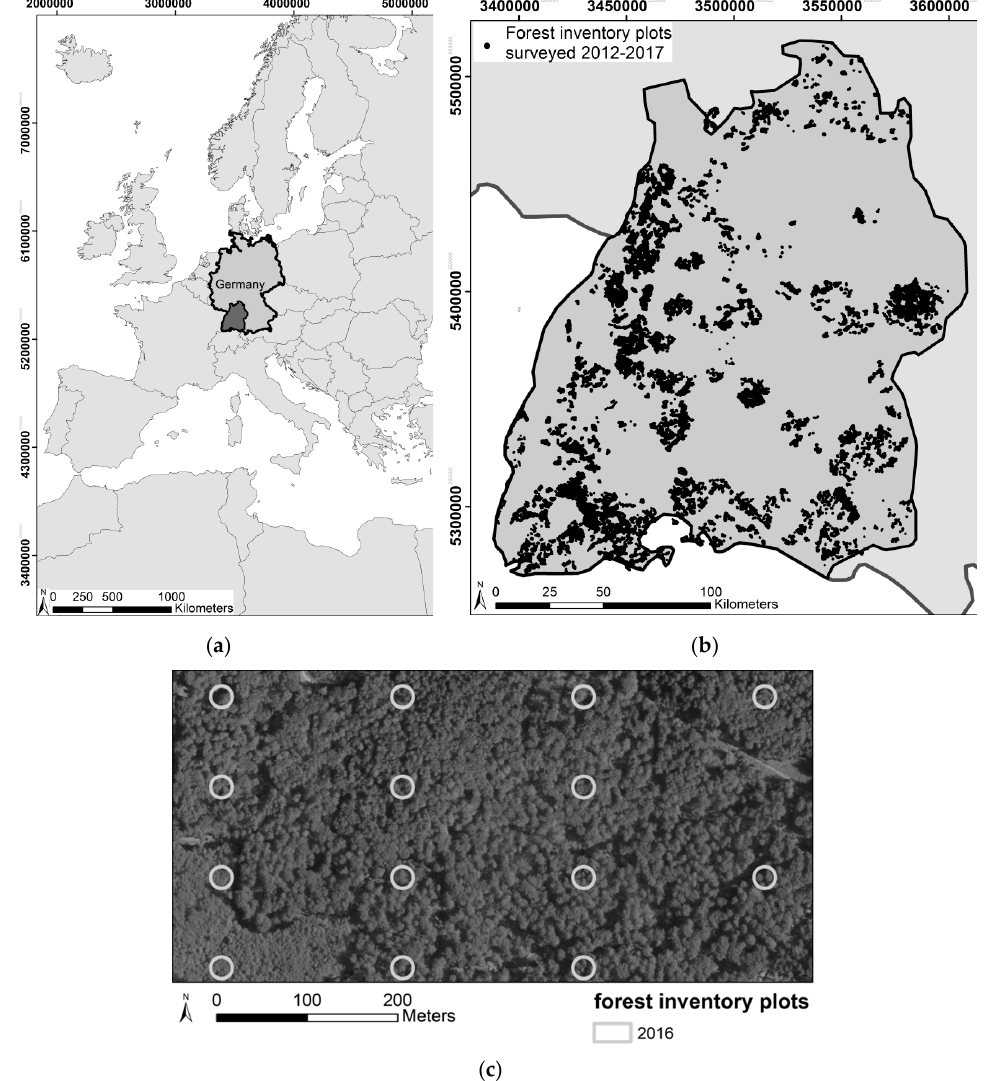
Figure 2. Study area: ( a ) Location of study area in south-west Germany, federal state of Baden-Württemberg; ( b ) location of the field plots surveyed between 2012–2017; ( c ) inventory design (100 m × 200 m grid) of 12 m radius plots; plots that were located on forest roads or were cut off due to borders were omitted.